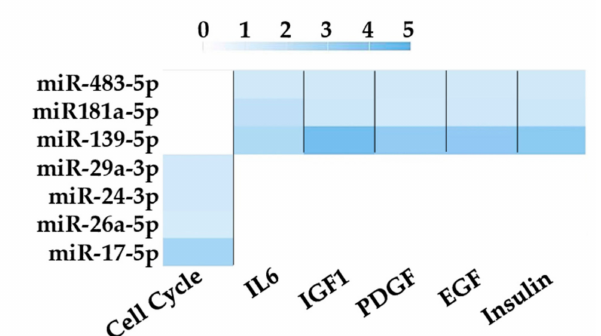
Figure 5. Pathways analysis based on target genes of unique miRNAs using miRPathDB. Enriched pathways ( p -value < 0.01) regulated by at least three miRNAs and their target genes are shown. Color code bar indicate the number of genes regulated by each specific miRNA for each pathway. Only validated miRNA–gene interactions were